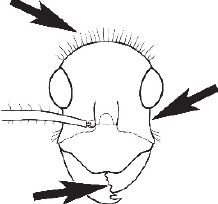
15 Metatibia armed with two rows of preapical spines ( JDM 199 ) (arid and semi-arid WA) (Fig. 24a–g) ............................................................ gracilipes (Fig. 23a–k) ........................................................................................ bagoti 16 Main teeth of mandible supplemented with small or indistinct denticles, total number of teeth and denticles ≥ six; in full-face view, head of minor worker indented below the eye, giving a bell-shaped appearance to the head capsule; workers matt, shagreenate, with very many long, flexuous setae over silvery pubescence (widespread but occasional) ( JDM 788 ) (Fig. 8a–g) ..........